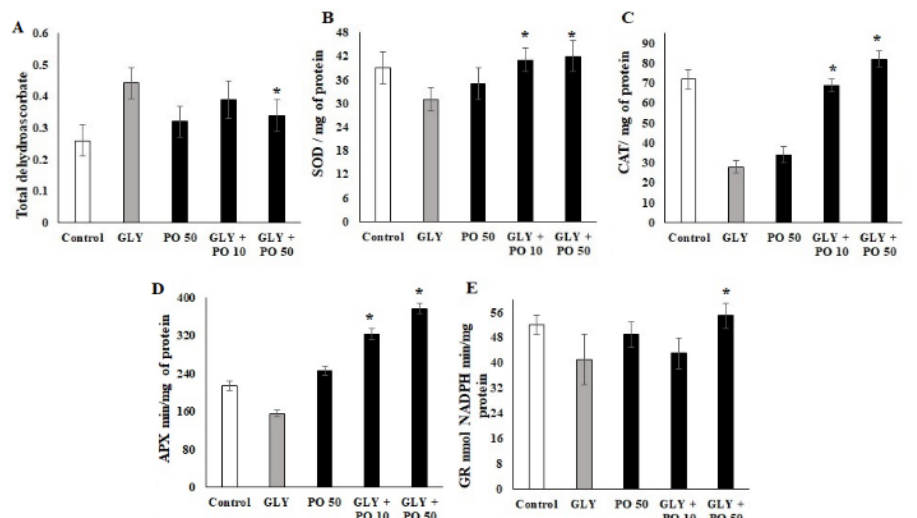
Figure 4. Tomato plants untreated (Control) or treated with GLY, PO 50, or a mix of both (GLY + PO 10; GLY + PO 50). ( A ) total dehydroascorbate, ( B ) SOD, ( C ) CAT, ( D ) APX and ( E ) GR concentration. Data presented are mean ± SD ( n ≥ 4). * indicate significant statistical differences between treatments and GLY-treated plants (Tukey’s test: p ≤ 0.05). Black bars indicate the treatment with PO and GLY + PO, the grey bar indicate GLY treatment and the white bar indicates the untreated control. 2.7. Effect of PO on Antioxidant and Metabolic mRNA Markers in S. lycopersicum CYO1A1450 gene showed the highest mRNA expression level (6.8 fold ± 0.4) in S. lycopersicum plants that were exposed to glyphosate. Whereas tomato plants challenged with GLY + PO 10 or GLY + PO 50 showed 4.2 and 2.9 fold, respectively (Figure 5A). Compared to GLY-treated tomato plants, those treated with pongamia oil (PO 50) alone, the mRNA expression of 9-cis-epoxycarotenoid dioxygenase ( NCED ), superoxide dismutase ( SOD1 ), arginine decarboxylase ( ADC ) and Lipooxygenase ( LIPO ) markers were not activated. On the other hand, cytochrome P 450 ( CYP1A1450 ), nitrate reductase ( NR ), and nitric oxide reductase ( NOS ) were significantly activated by PO 50 treatment. The comparative study clearly explained that PO 50 with GLY exposure regulates the antioxidant and metabolic expression factors and is merely significant to non-treated groups (Figure 5A,B). mRNA expression of NCED , ADC, and CYP1A1450 actively responded to treatment (GLY exposure showed 3.5, 2.9, and 6.6 compared to 2.3, 1.7, and 2.9 mRNA fold in GLY + PO 50-treated group) and opened a new treatment procedure to control herbicide tolerance in S. lycopersicum .